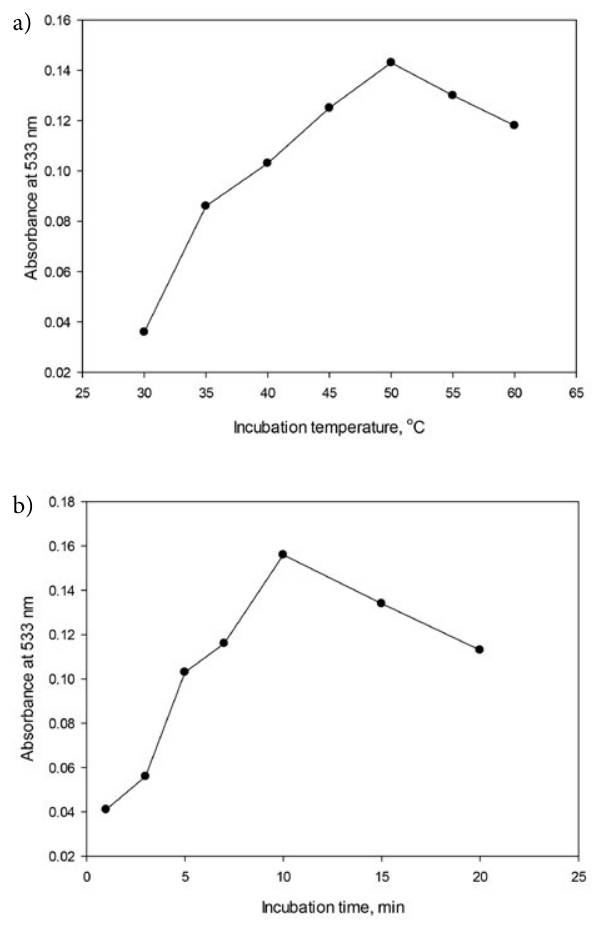
Figure 4. The influence of (a) incubation temperature and (b) incu- bation time at pH 6.0 on the analytical signal. Conditions: 50 μg L –1 V(V), 0.8 mmol L –1 B-R buffer at pH 6.0, 1.6 µmol L –1 pyrogallol, 2.0 µmol L –1 safranin T, 6.0 mmol L –1 KCl solution, and 0.05% ( w/v ) Triton